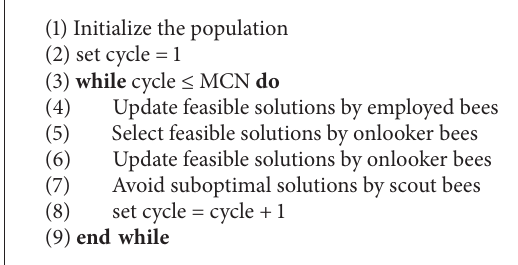
Algorithm 1: The framework of the standard ABC